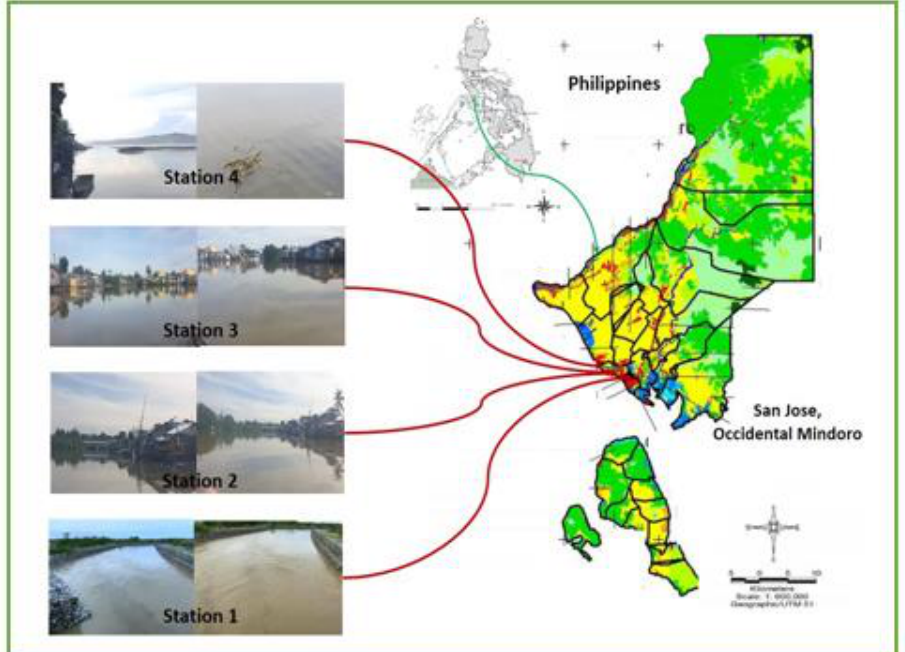
Fig. 1: Geographic location of the study sampling stations at San Jose, Occidental Mindoro, Philippines